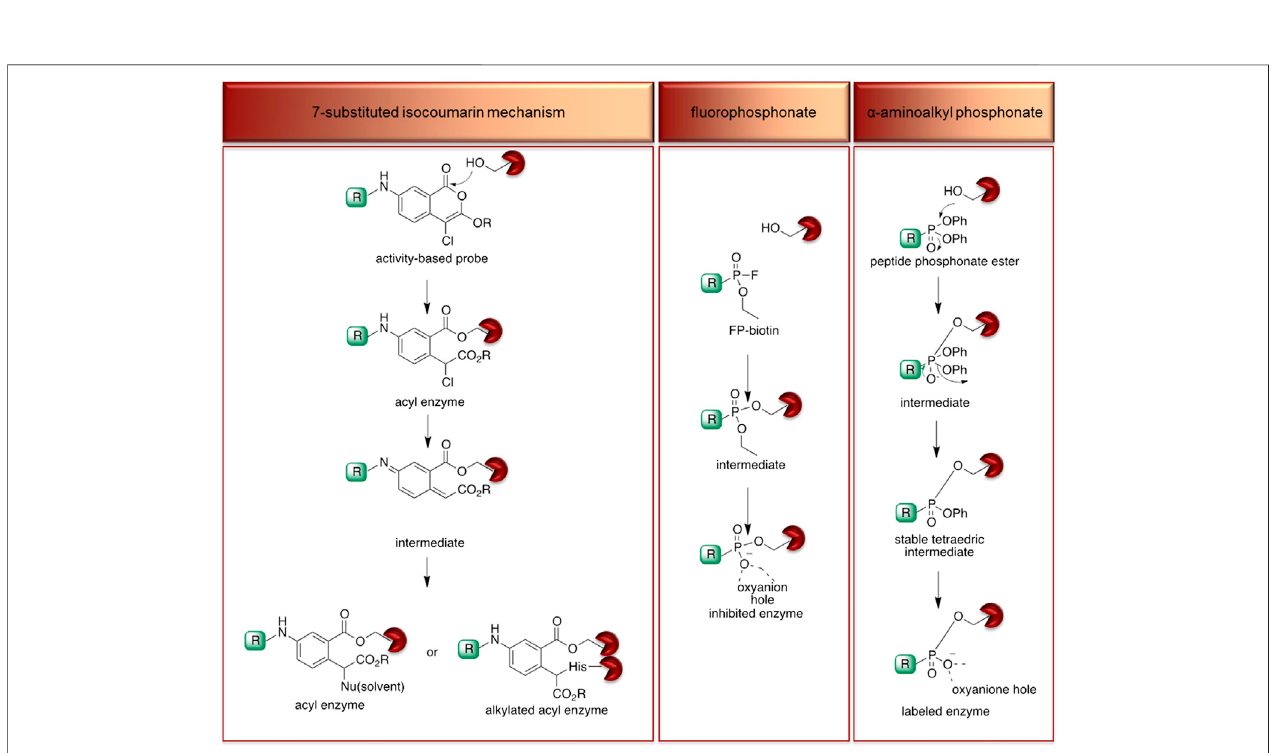
FIGURE 5 | Proposed mechanism of serine protease active site inhibition by different serine protease reactive groups.